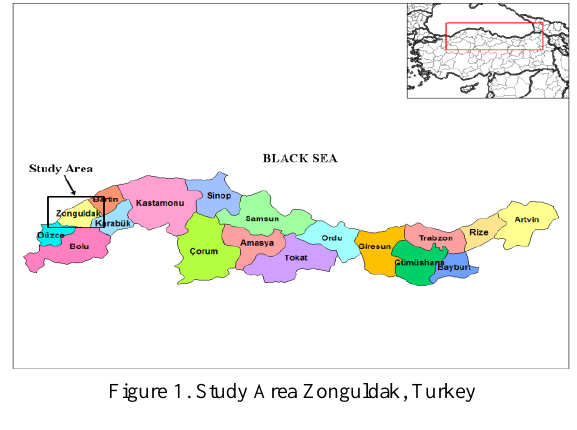
Figure 1. Study Area Zonguldak,